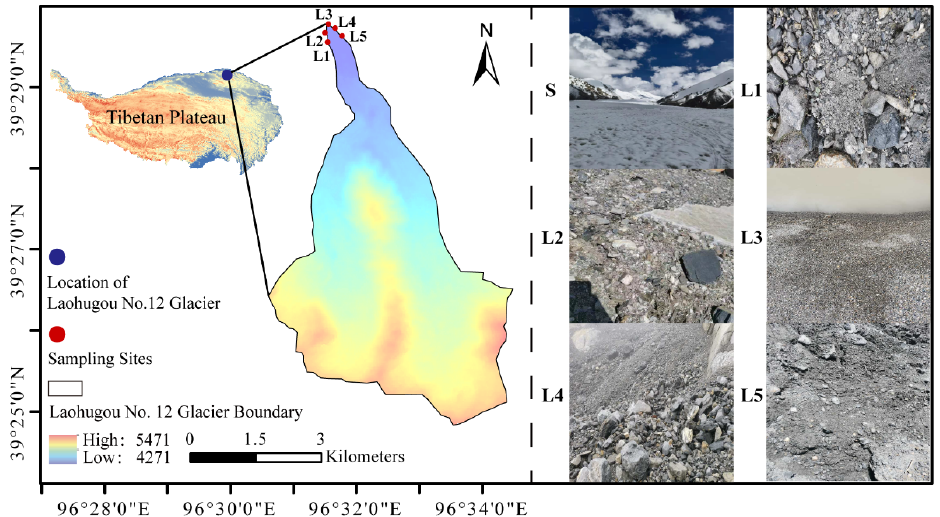
Figure 1. Location of Laohugou Glacier No. 12: Overall view of the glacier (S), and sampling sites on the moraine (L1–L5).